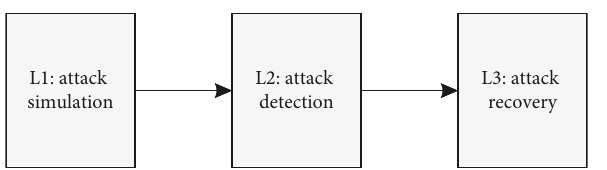
Figure 3: Flowchart diagram of design.